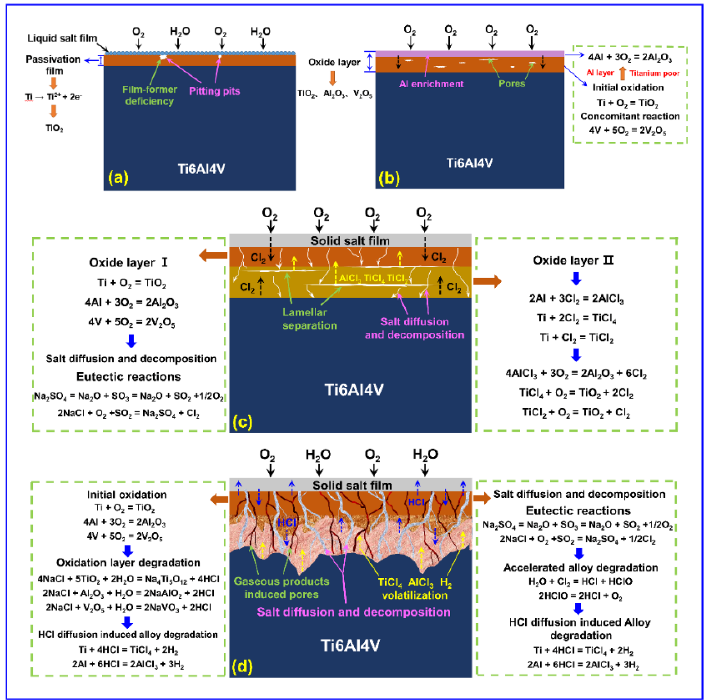
Figure 9. Corrosion damage mechanism diagrams of all tested samples: ( a ) salt spray; ( b ) oxidation; ( c ) hot salt corrosion; and ( d ) hot salt–water vapor synergy.